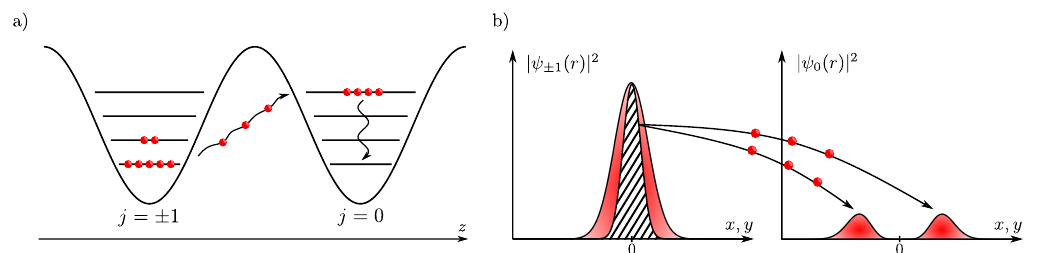
Figure 4: Schematic representation of the tunneling process between a full and an empty lattice site in terms of a) the single-particle eigenstates as well as b) the corre- sponding transversal wave functions. Due to the interaction shift a resonant transport between the single-particle ground states in neighboring sites with different occupa- tion numbers is blocked and particles dominantly tunnel into higher radial modes of the initially empty site, which cannot accurately be expressed by our variational ansatz.